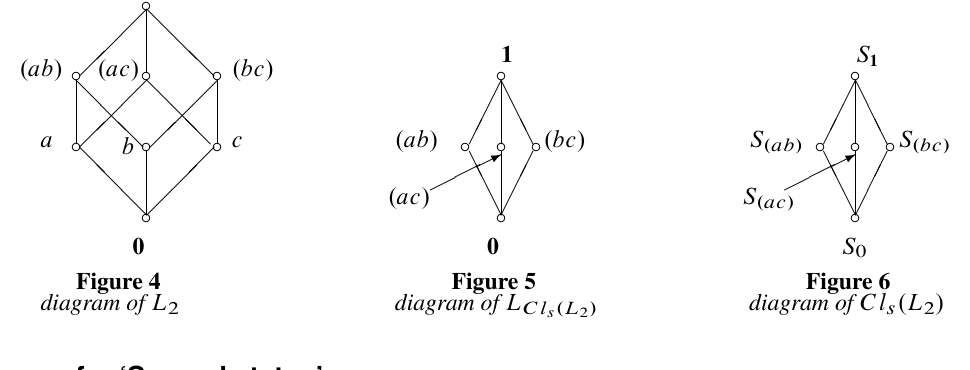
Figure 6 diagram of Cl s .L 2